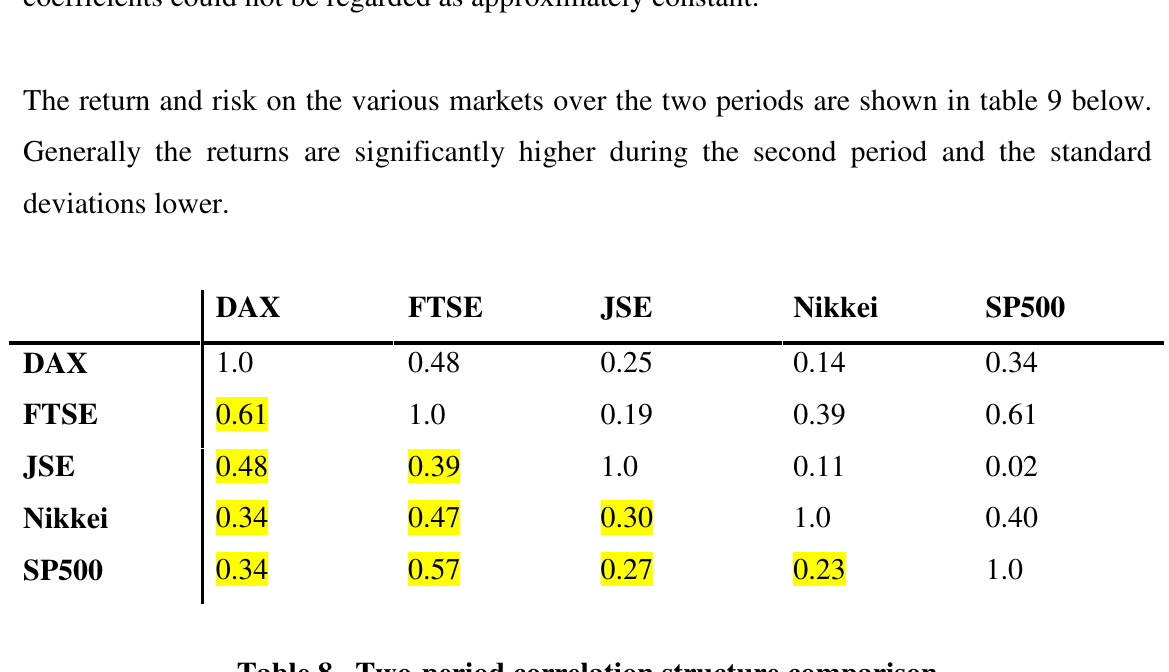
Table 8. Two-period correlation structure comparison